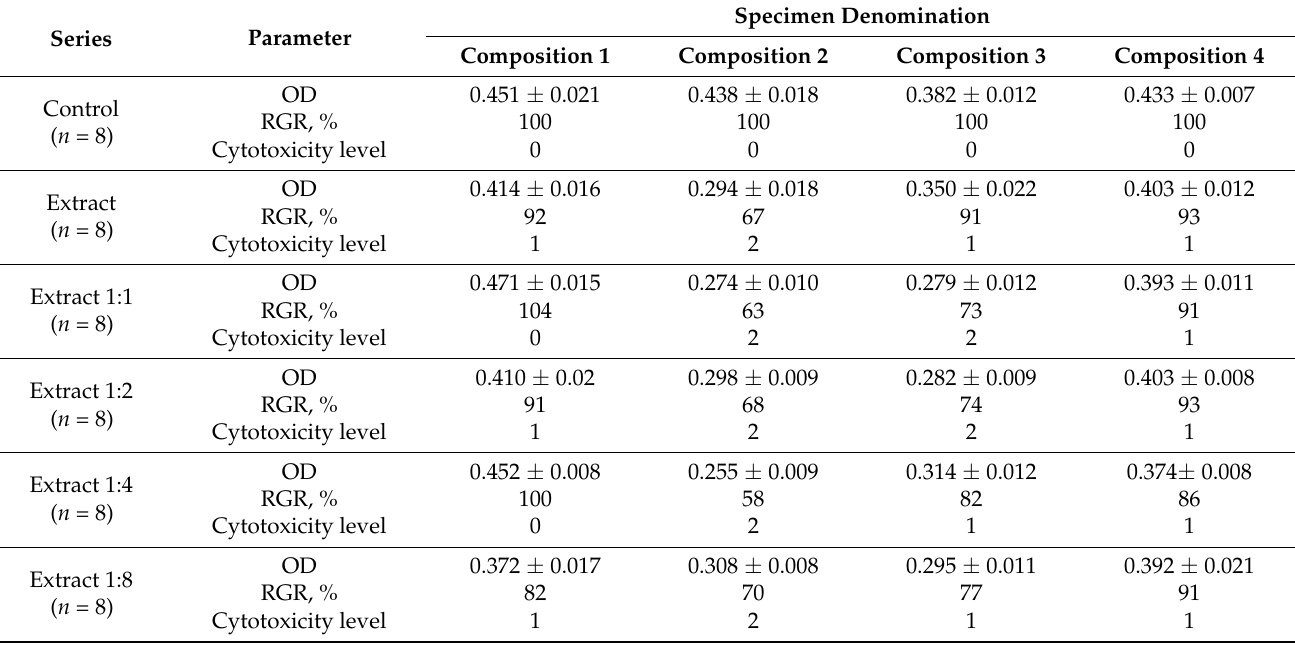
Table 2. Cytotoxicity evaluation of polyurethane polymer specimens at 1 day extraction.